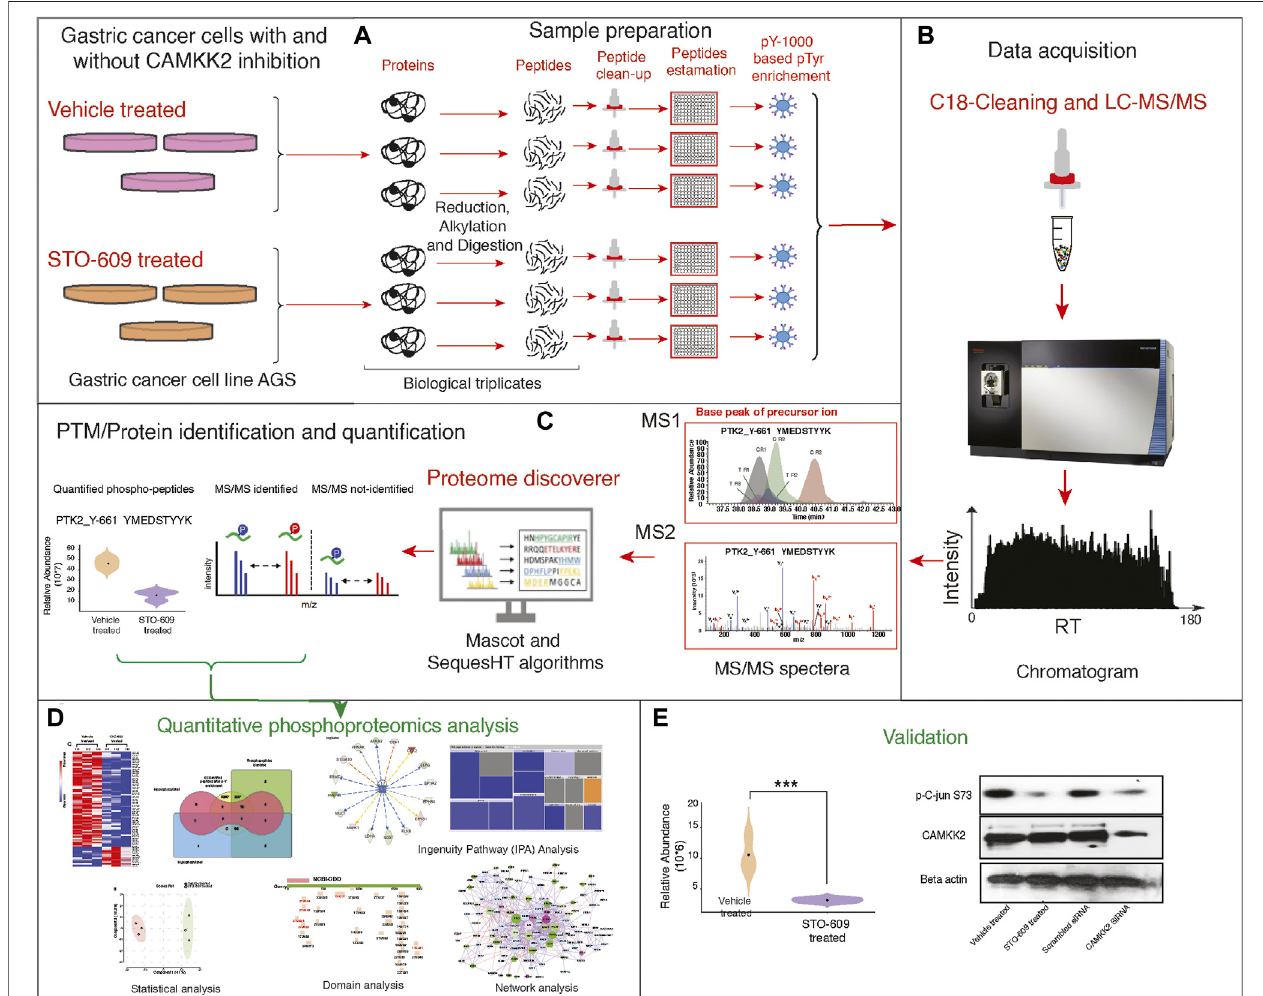
FIGURE 1 | Detailed experimental work fl ow for phospho-(Y)-proteomic analysis, data analysis, and functional validation in gastric cancer cells between STO-609- treated and DMSO control conditions. (A) Schematic representation adapted for sample preparation for identi fi cation and quanti fi cation of phospho-(Y)-proteomic changes in gastric cancer cells (AGS) treated with STO-609 and vehicle control (DMSO). (B) Schematic representation LC-MS/MS analysis. (C) Schematic representation for PTM/protein identi fi cation and quanti fi cation from LC-MS/MS data using proteomic platform Proteome Discoverer. (D) Bioinformatics analysis/ data analysis of proteomic data obtained in gastric cancer cells (AGS) treated with STO-609 and vehicle control (DMSO). (E) Validation of protein expression identi fi ed from proteomic data analysis.